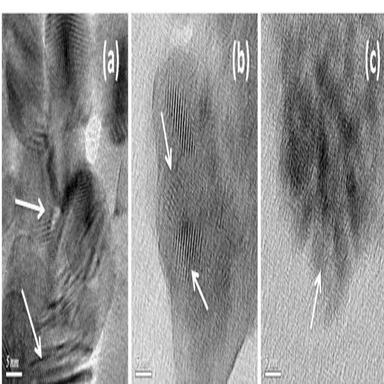
HRTEM image of (a) Cu-PFBA, (b) Cu-SA and (c) Cu-TCPFOSi system.